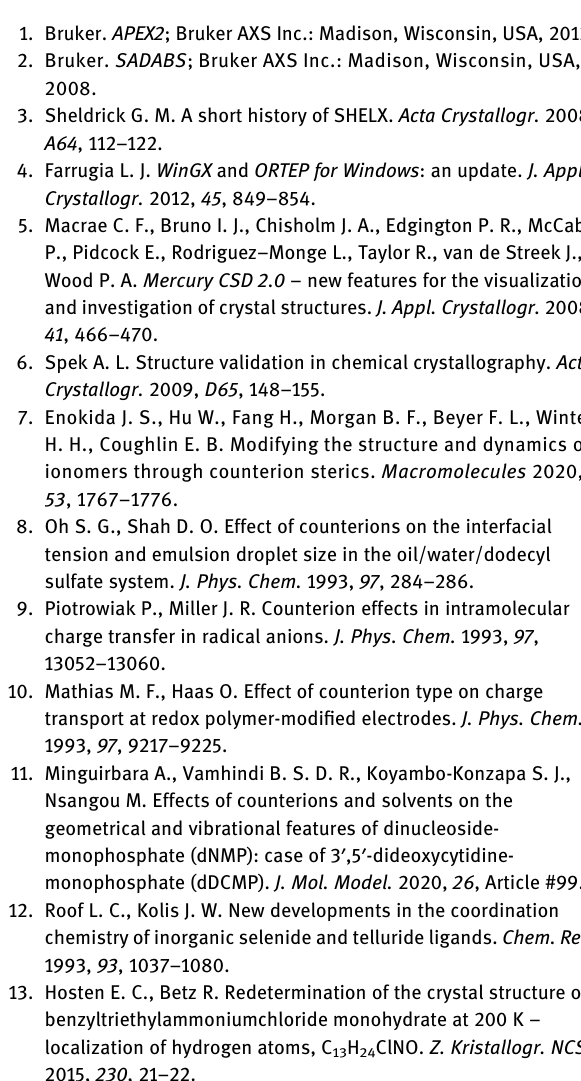
Table  : Fractional atomic coordinates and isotropic or equivalent isotropic displacement parameters (Å  ).